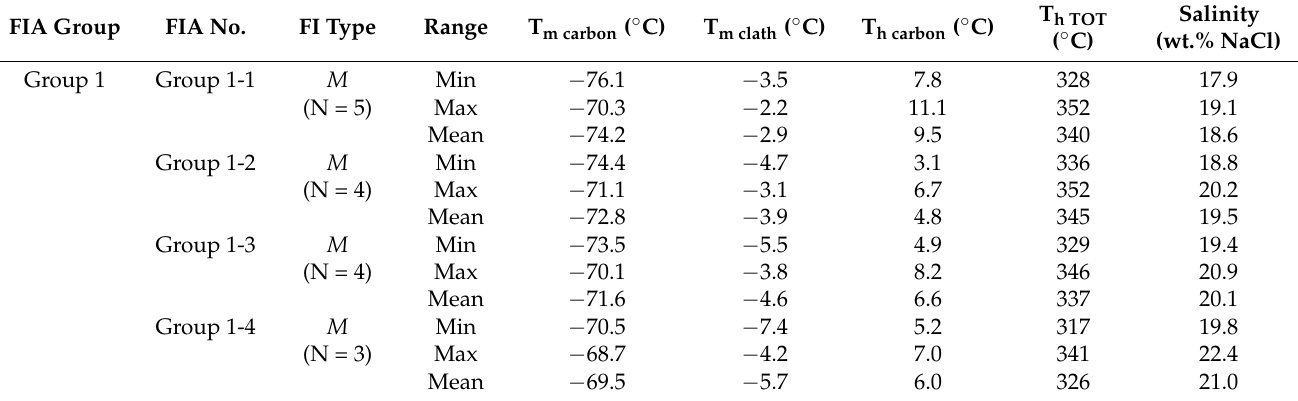
Table 2. Summary of the microthermometric data and calculated parameters for Group 1 FIAs from stage I